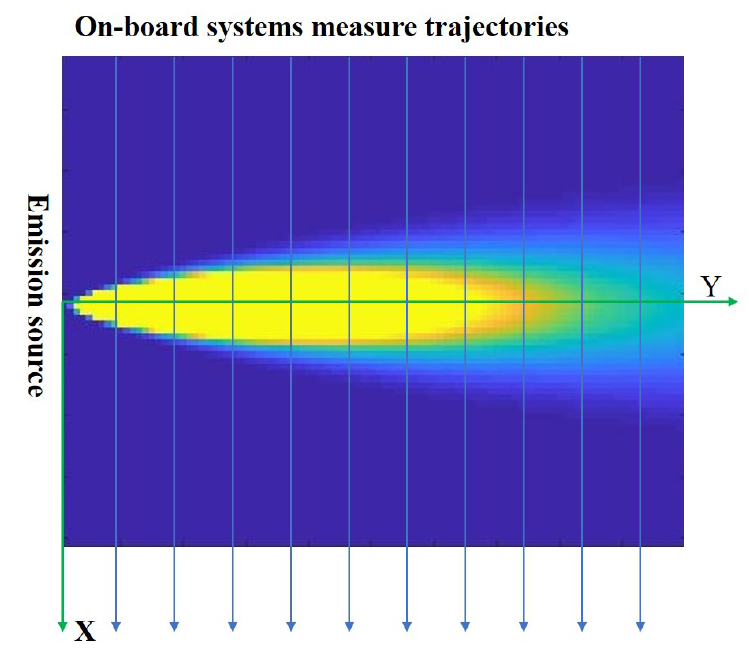
Figure 6. Schematic diagram of the different measurement trajectories of the mobile